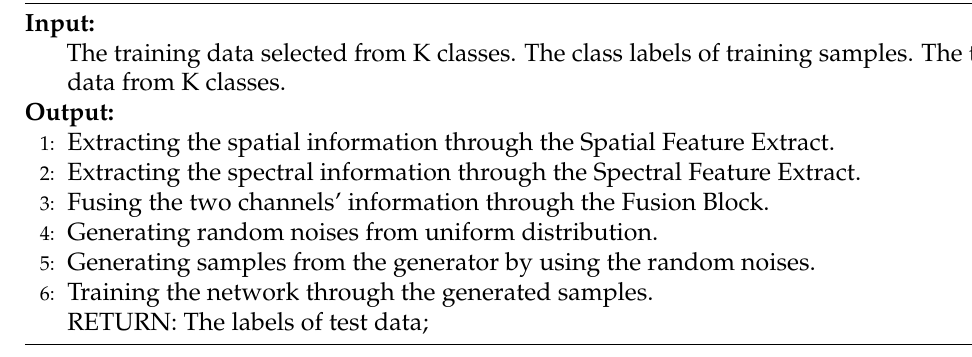
Figure 6. The Generator. Algorithm 1 The framework of our